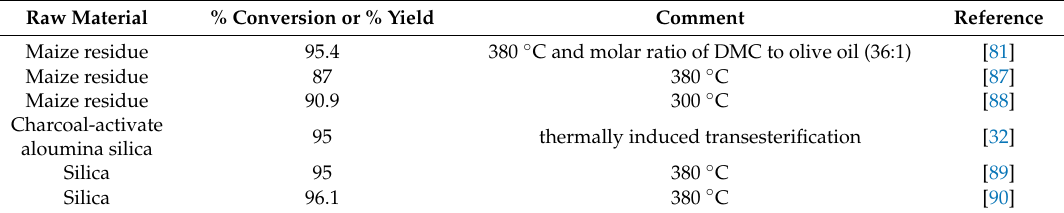
Table 3. Pseudo-catalytic transesterification/esterification with maze residue biochar and silica as an inert porous